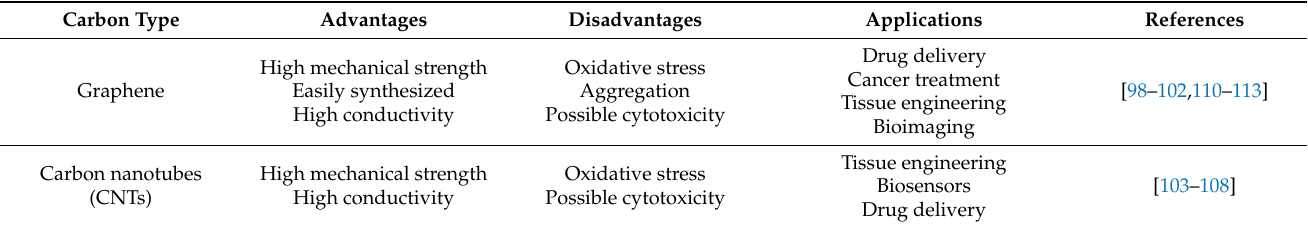
Table 3. Properties and applications of graphene and carbon